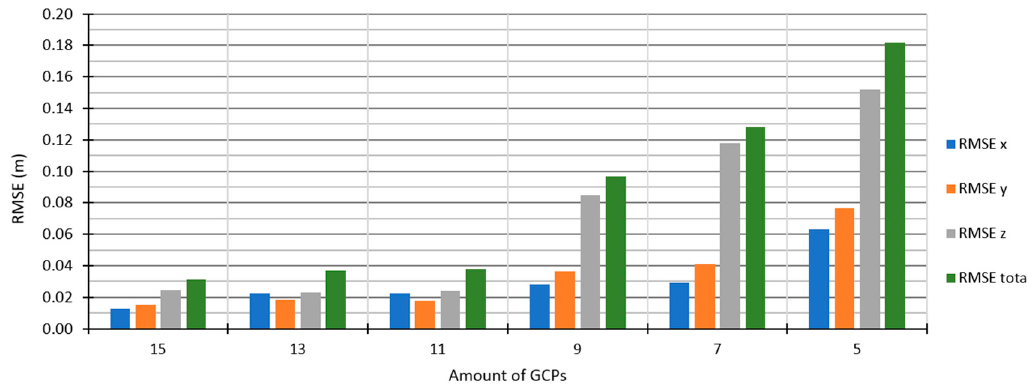
ff erent amounts of GCPs tested on variation Figure 11. Check point RMSEs of the different amounts of GCPs tested on variation I. Figure 11. Check point RMSEs of the di